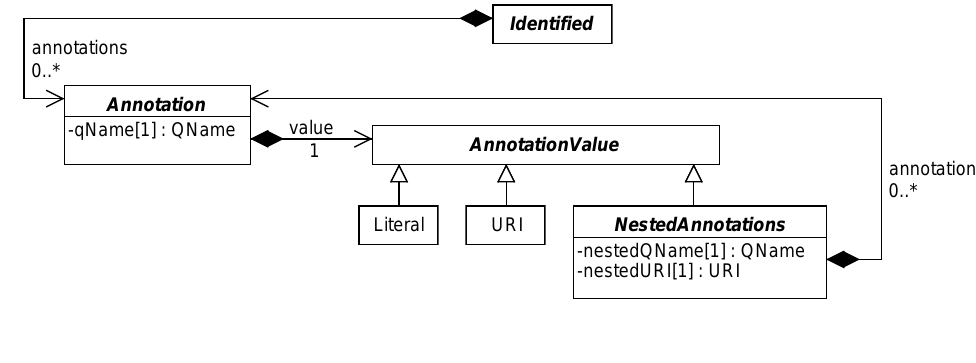
Figure 24: Diagram of the Annotation class and its association with Identified and AnnotationValue objects, which is used for annotating SBOL entities with application specific data.